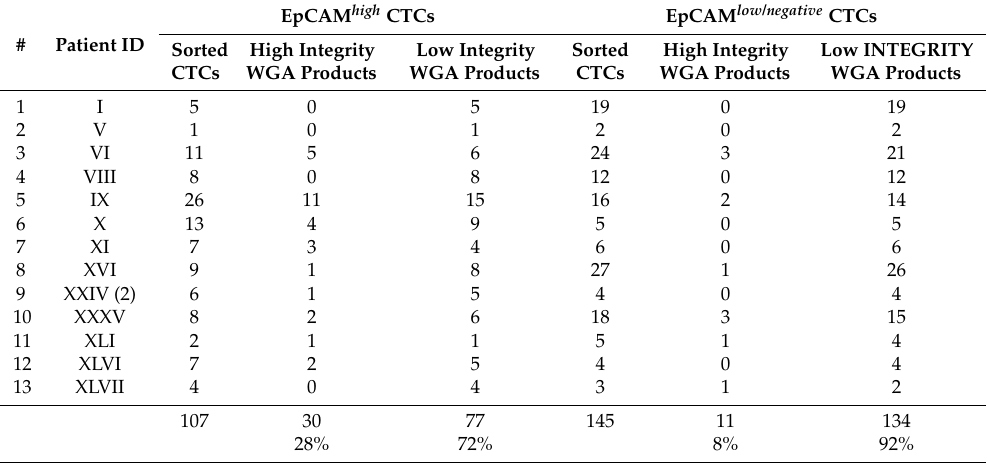
Table 1. WGA products of patients matched EpCAM high and EpCAM low/negative cells. A cohort of 145 EpCAM low/negative and 107 EpCAM high circulating tumor cells (CTCs) was processed for whole genome amplification (WGA). EpCAM low/negative CTCs show a lower genomic integrity than EpCAM high CTCs (8% vs. 28%). #: number of patients involved in the WGA of CTCs.